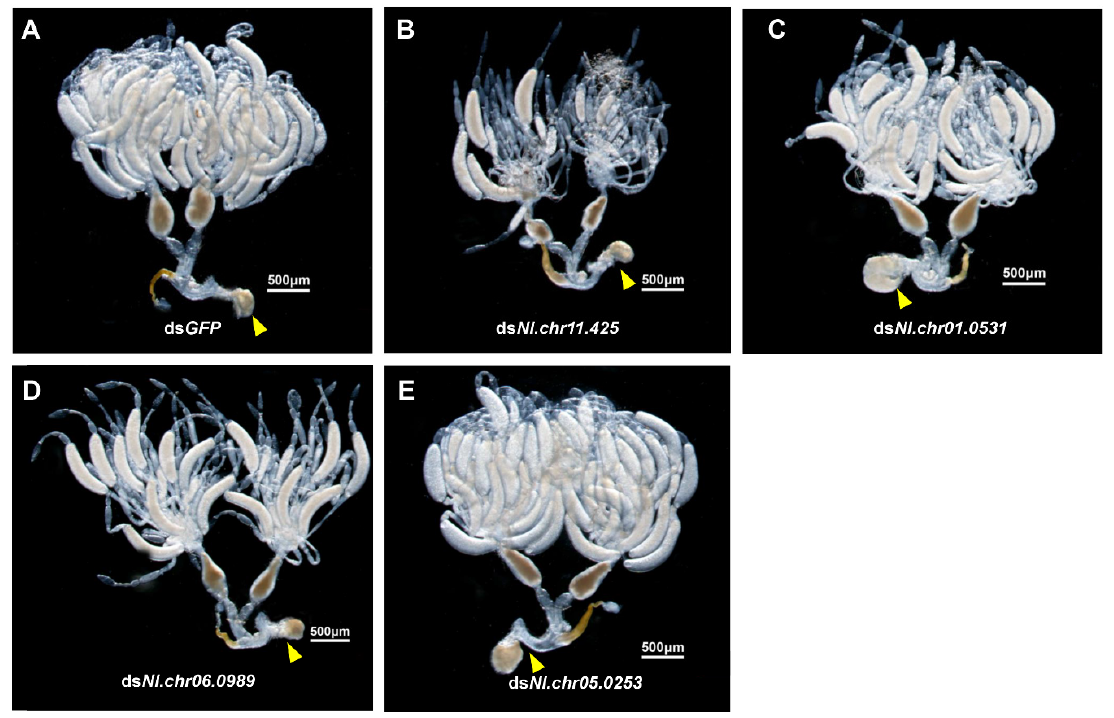
Figure 5. Phenotypes of ovary development after knockdown of 4 genes responsive to bacteria: ( A – E ) Ovaries dissected from the females treated with ds GFP , ds Nl.chr11.425 , ds Nl.chr01.0531 , ds Nl.chr05.0253 , and ds Nl.chr06.0989 for 72 h, respectively. Yellow triangle: copulatory bursa.